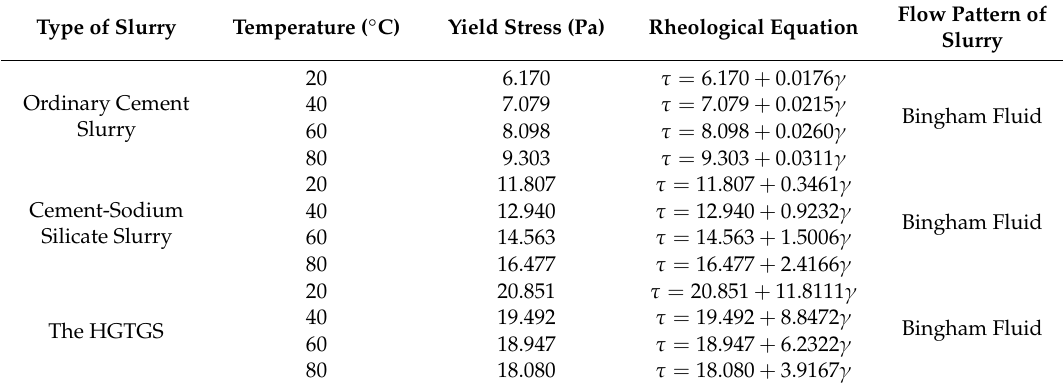
Figure 15. The rheological curve of the HGTGS at different temperatures. Table 7. The rheological equations of three kinds of slurries and their flow patterns at different temperatures. Type of Slurry